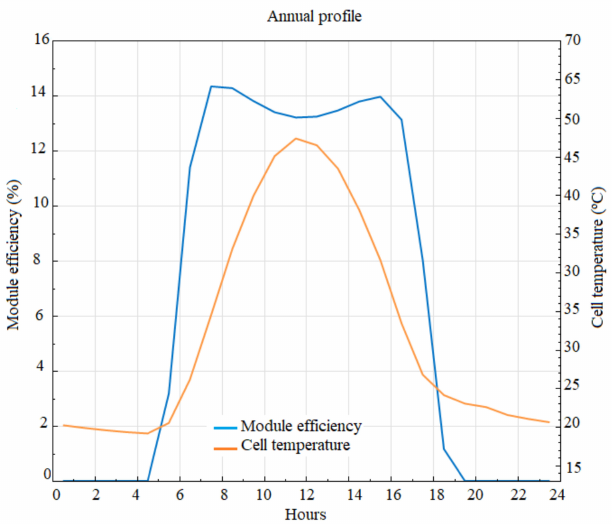
Figure 16. Effect of heating on the module efficiency (tilt angle = 20 ◦ and azimuth angle = 10 ◦ ).